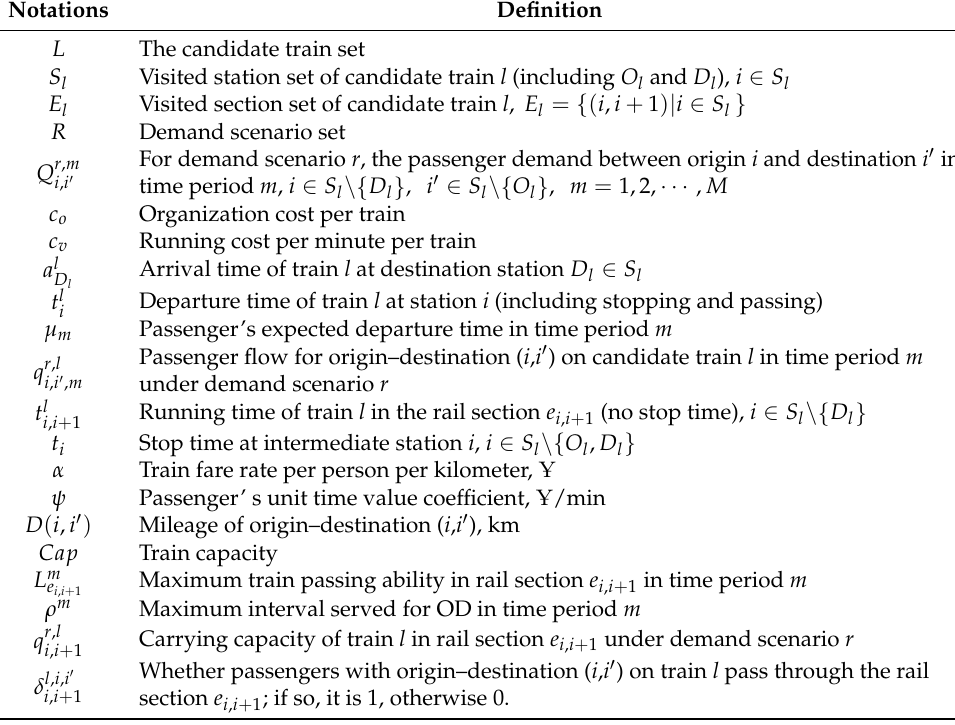
Table 1. The main sets and parameters involved in the